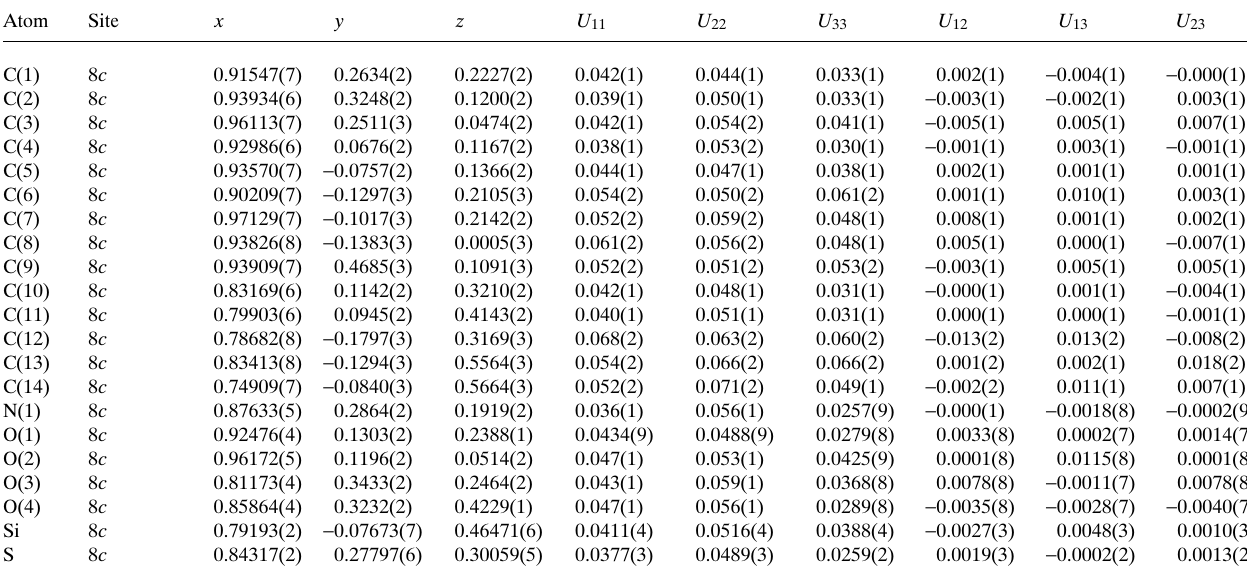
Table 3. Atomic coordinates and displacement parameters (in Å 2 )